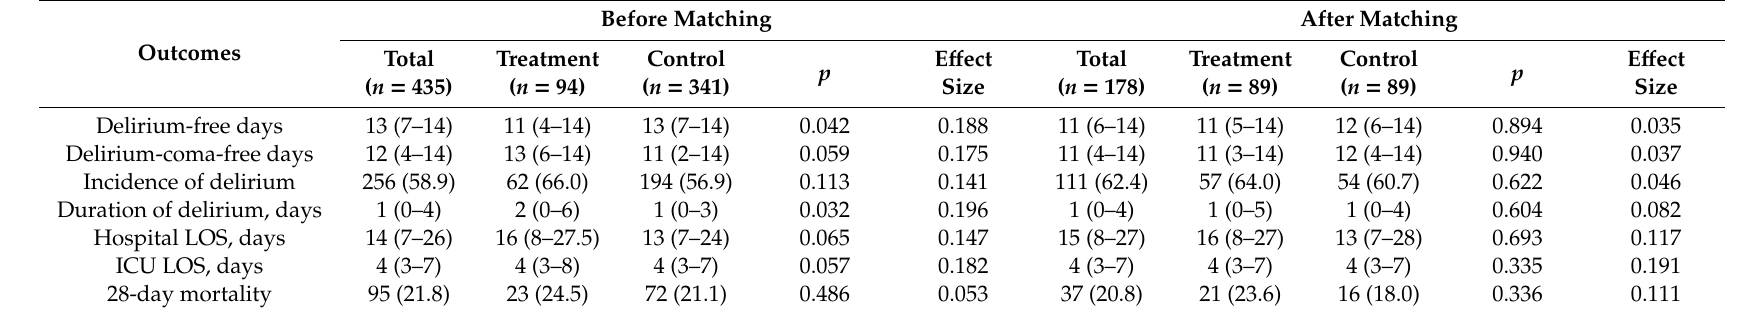
Table 2. Primary and secondary